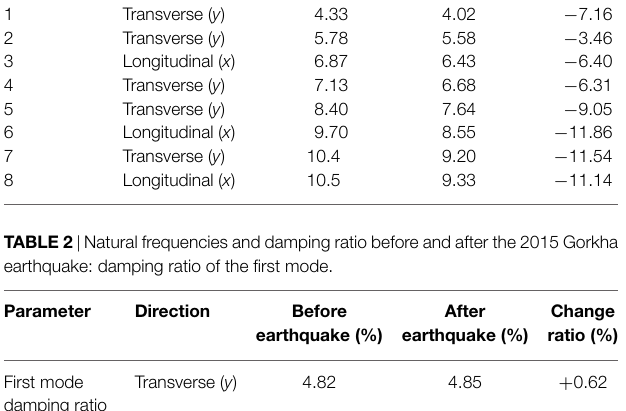
TABLE 1 | Natural frequencies and damping ratio before and after the 2015 Gorkha earthquake: natural frequency. Mode no.